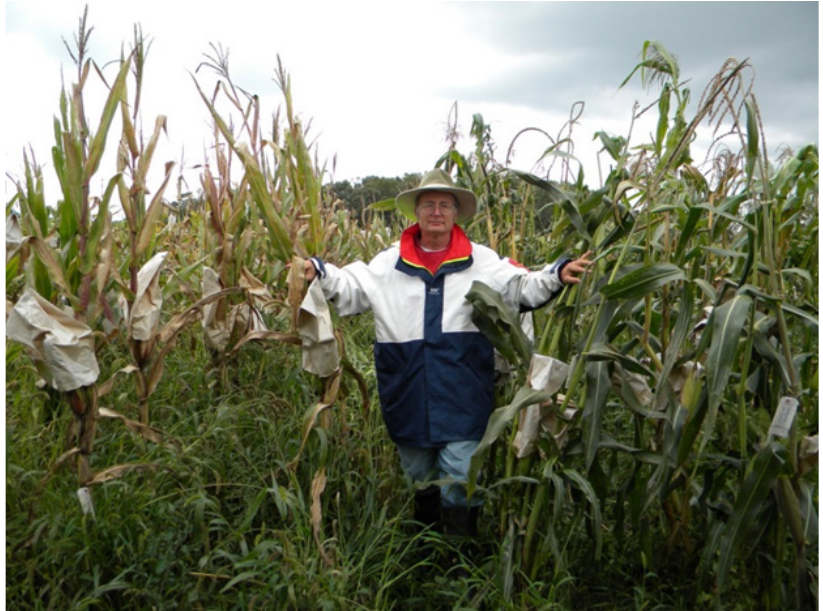
Figure 5: Conventionally bred inbred B73 on the far left and accessions of two Mexican landraces (LR 36 and LR8) on the right with similar flowering times. Plants were grown on a N-limited site near Elkhorn Wisconsin in September, 2009. The chlorophyll score for B73 was 43 and the dry root weight per plant was 130 grams. The chlorophyll scores for the two Mexican accessions were 56 and 59 and the root weights per plant were 57 and 100 grams of dry matter,